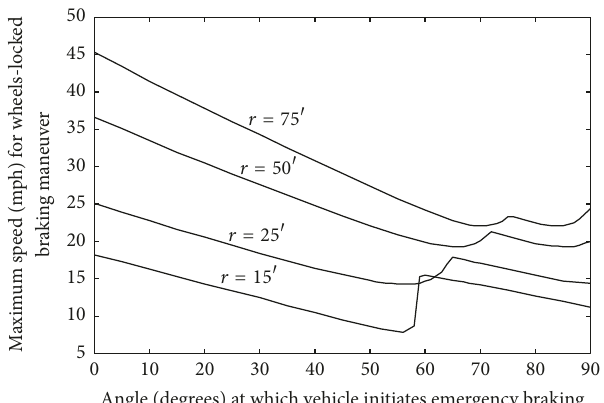
Figure 4: Curves depicting maximum speed ( V WLB ) at which a wheels-locked braking maneuver can be